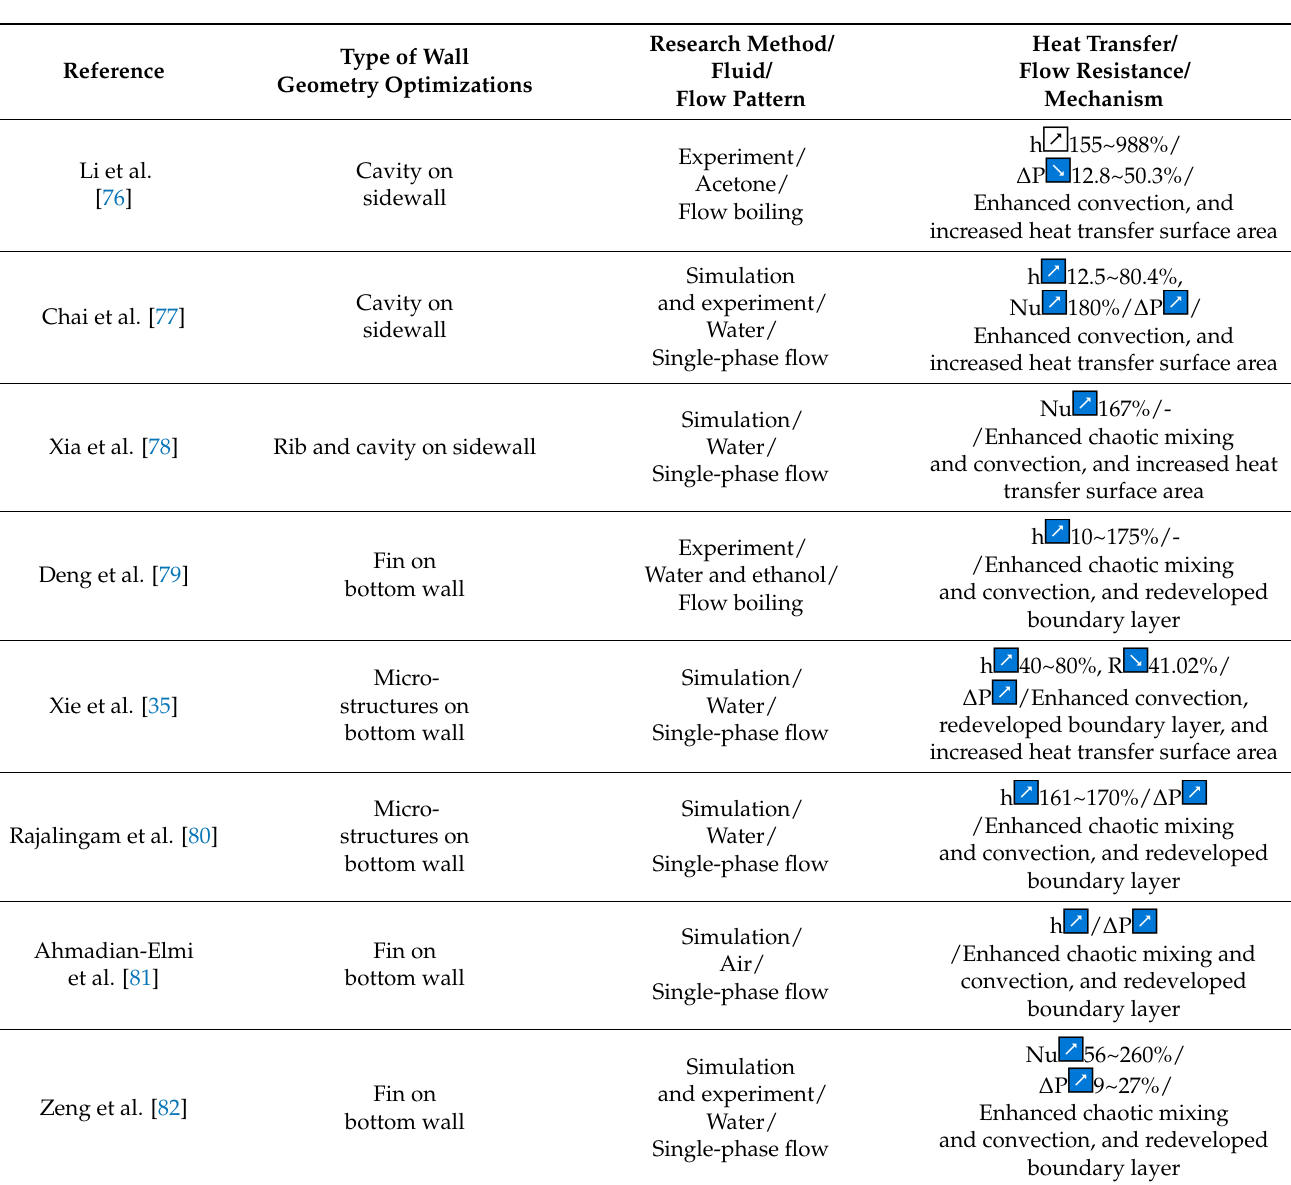
Table 3. Cont. Table 3. Selected studies of geometric optimization on sidewall and bottom wall of the microchan- nel on heat transfer. Table 3. Selected studies of geometric optimization on sidewall and bottom wall of the microchan- nel on heat transfer. Table 3. Selected studies of geometric optimization on sidewall and bottom wall of the microchan- Table 3. Selected studies of geometric optimization on sidewall and bottom wall of the microchan- nel on heat transfer. nel on heat transfer. Table 3. Selected studies of geometric optimization on sidewall and bottom wall of the microchan- nel on heat transfer.